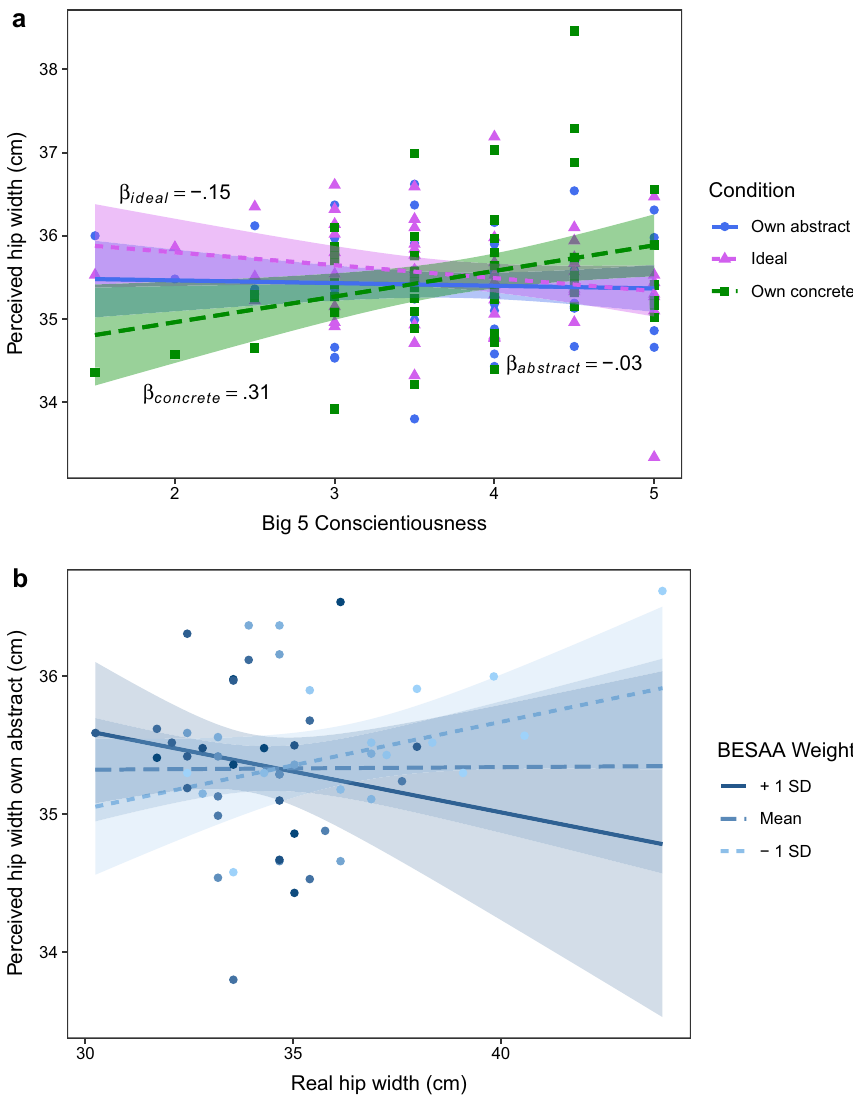
Figure 3. Effects of psychological traits. (a) A mixed linear effects model indicated that Big 5 Conscientiousness significantly predicted perceived hip width for own concrete representations ( Which of these two bodies looks most like the body you would use for online shopping? ). (b) A marginally significant interaction was observed between the Weight scale scores of the Body Esteem Scale for Adolescents and Adults (BESAA) and real hip width when predicting perceived hip width in the own abstract condition ( Which of these two bodies looks most like your own?